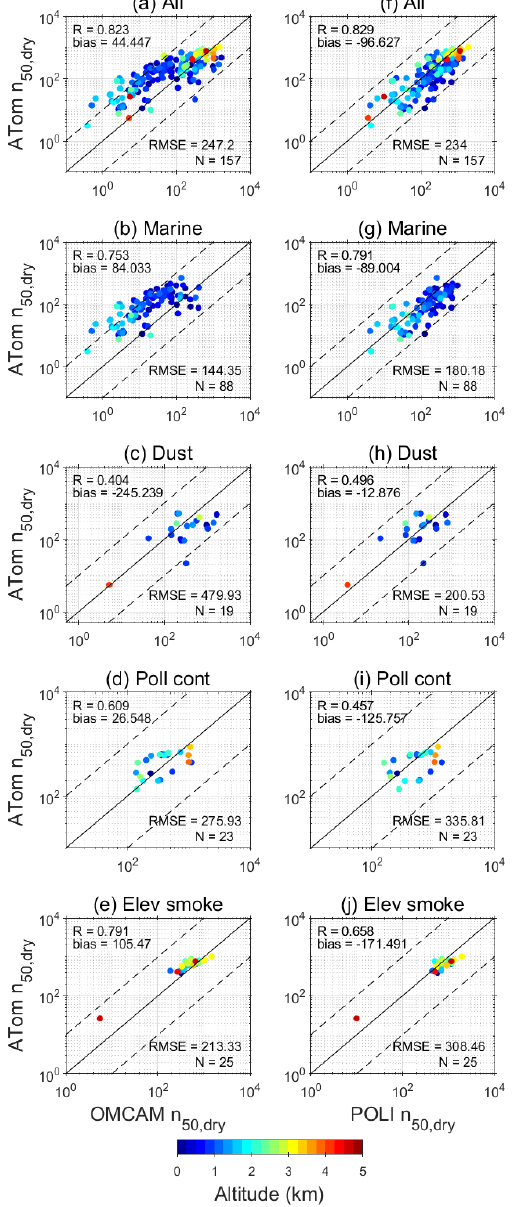
Figure 6. Comparison of n 50 , dry (in cm − 3 ) retrieved from ATom and CALIPSO measurements using OMCAM (a–e) and POLIPHON (f–j) for 240m altitude bins between 0 and 5km for all the identified intersections. The bins where marine (b, g) , dust (c, h) , polluted continental (d, i) , and elevated smoke (e, j) aerosols are dominant are separately shown. The Spearman’s correlation coef- ficient ( R ), bias, root mean squared error (RMSE), and the sample space ( N ) are given in the